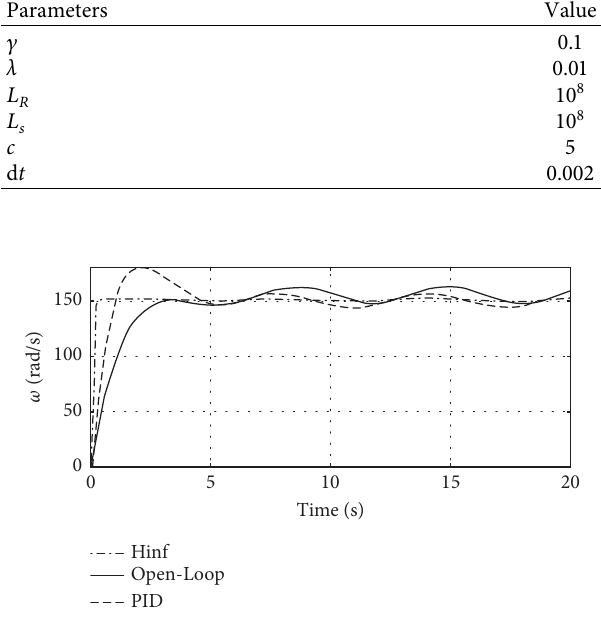
Figure 3: Te angular velocity of the frst order system for τ � 0 . 1s for sinusoidal disturbance.